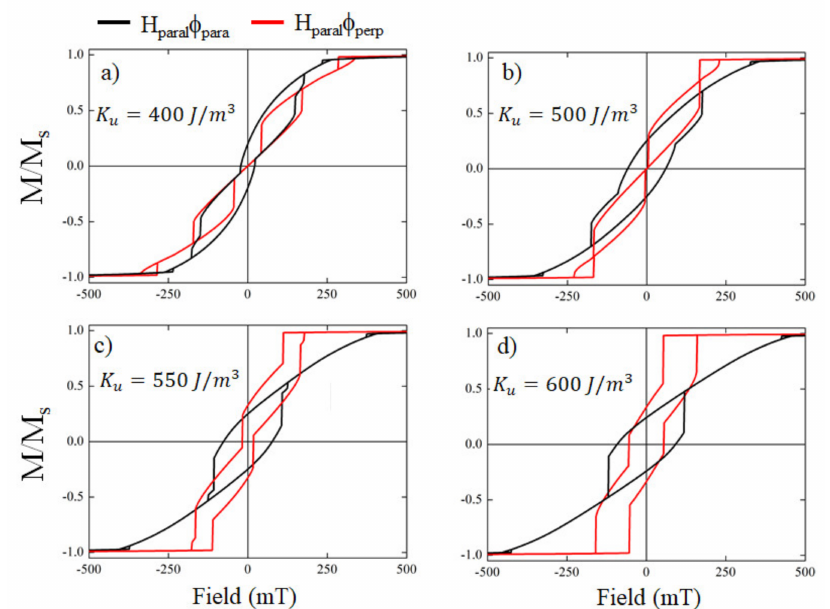
Figure A3. Hysteresis loop of a single sample R-mask when a uniaxial anisotropy of magnitude ( a ) K u = 400 J/m 3 , ( b ) K u = 500 J/m 3 , ( c ) K u = 550 J/m 3 and ( d ) K u = 600 J/m 3 , is induced in the H paral Φ perp